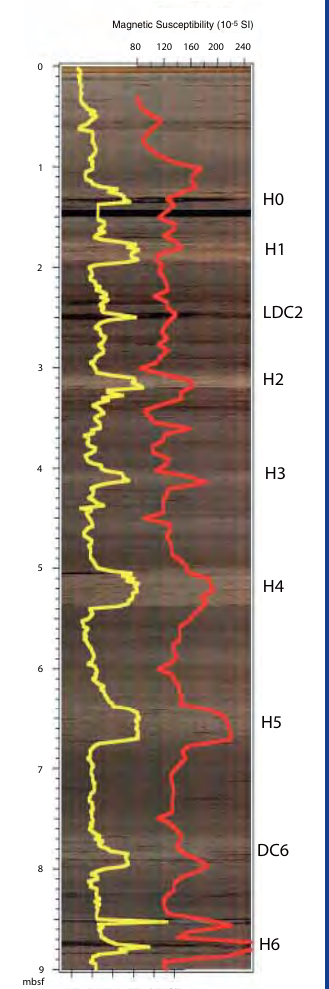
Figure 2. Detrital layers at Hole U1303B, in the uppermost 9 mbsf. Enhanced digital image scan overlain by susceptibility (red, right) and gamma ray attenuation density (yellow, left). Detrital layer nomenclature from Stoner et al. (2000) for Core MD95-2024